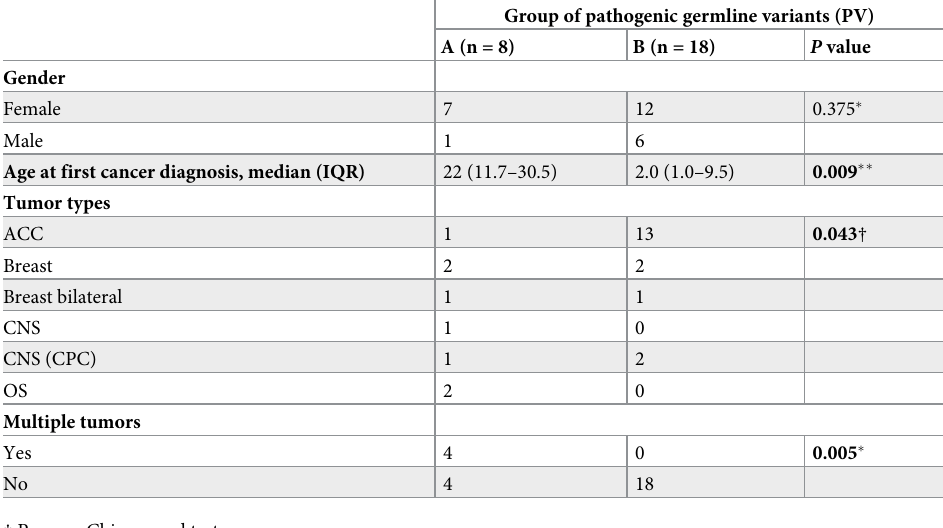
Table 3. Association of gender, age at first tumor diagnosis, tumor type and development of multiple tumors among carriers of different groups of germline PV TP53 (groups A and